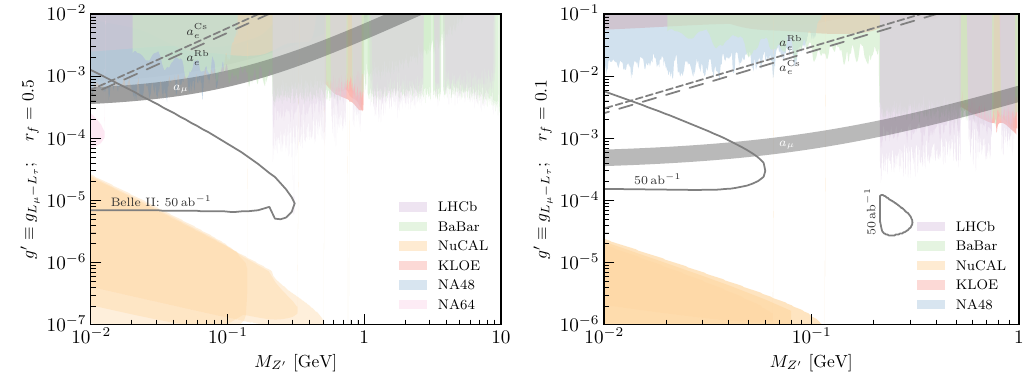
Figure 7 . Similar to figure 5, the black contour can be probed with displaced vertex searches at Belle II for a L µ − L τ gauge boson with r f = 0 . 5 (left) and r f = 0 . 1 (right). As is evident for the r f = 0 . 1 case, smaller values of the electron coupling reduces the production and hence relaxes the